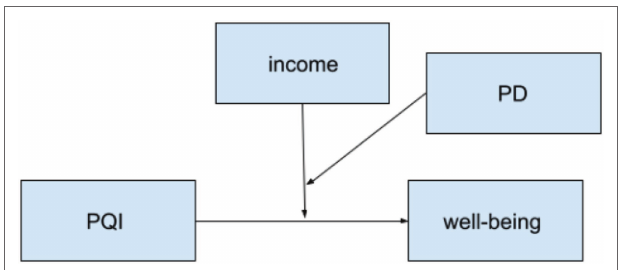
FIGURE 1 | Hypothesized three-way moderation model for both countries.